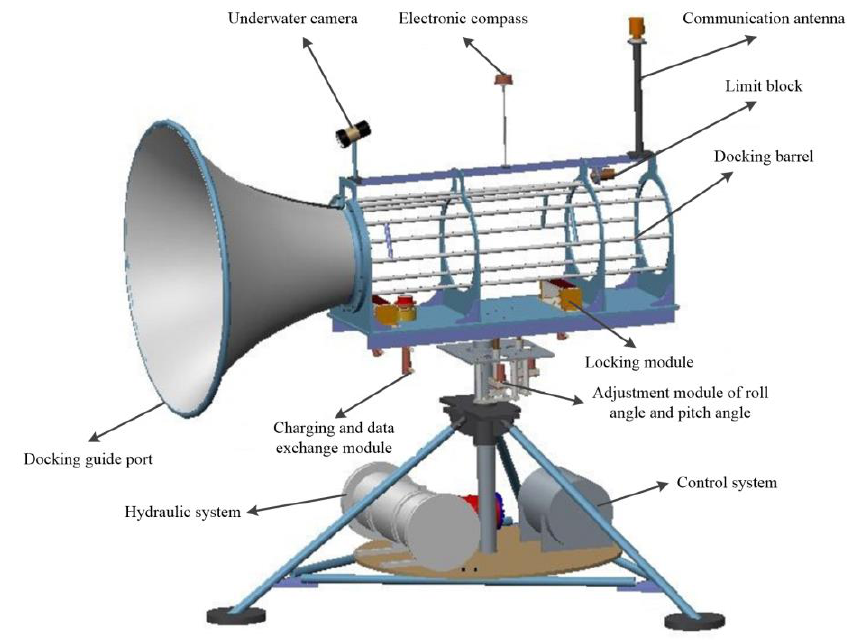
Figure 1. Designed AUV docking device with multi-degree freedom.